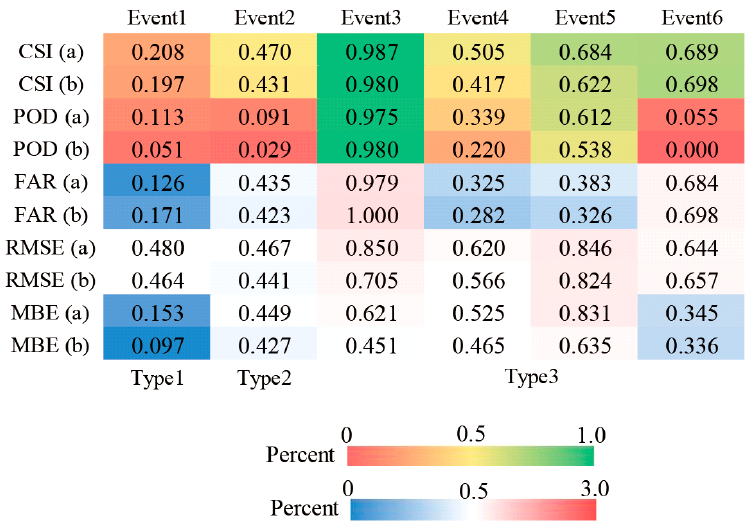
Figure 5. Evaluation values of the indices for the spatial rainfall distribution of the six storm events: ( a ) WRF-only; ( b ) the fully coupled WRF/WRF-Hydro.